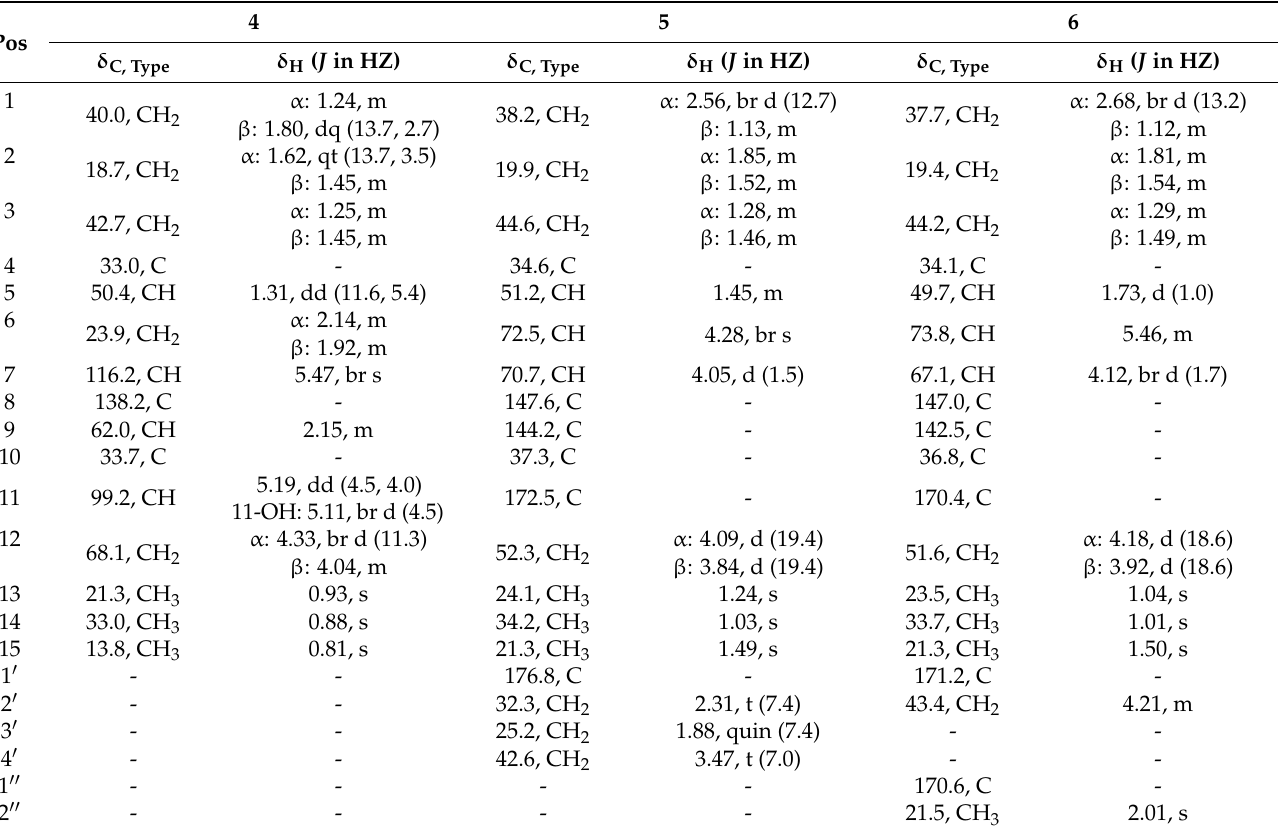
Table 2. NMR spectroscopic data ( 13 C ( δ C ), 125 MHz and 1 H ( δ H ), 500 MHz) for isodrimeniol ( 4 , acetone- d 6 ), the glycinyl derivative of deacetylugandensolide ( 5 , methanol- d 4 ), and the 4-aminobutyl derivative of ugandensolide ( 6 , acetone- d 6